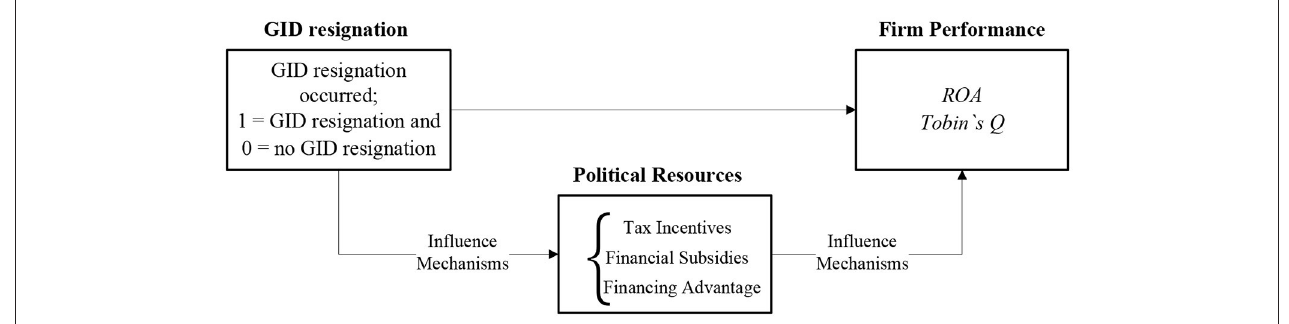
FIGURE 1 | Research logic